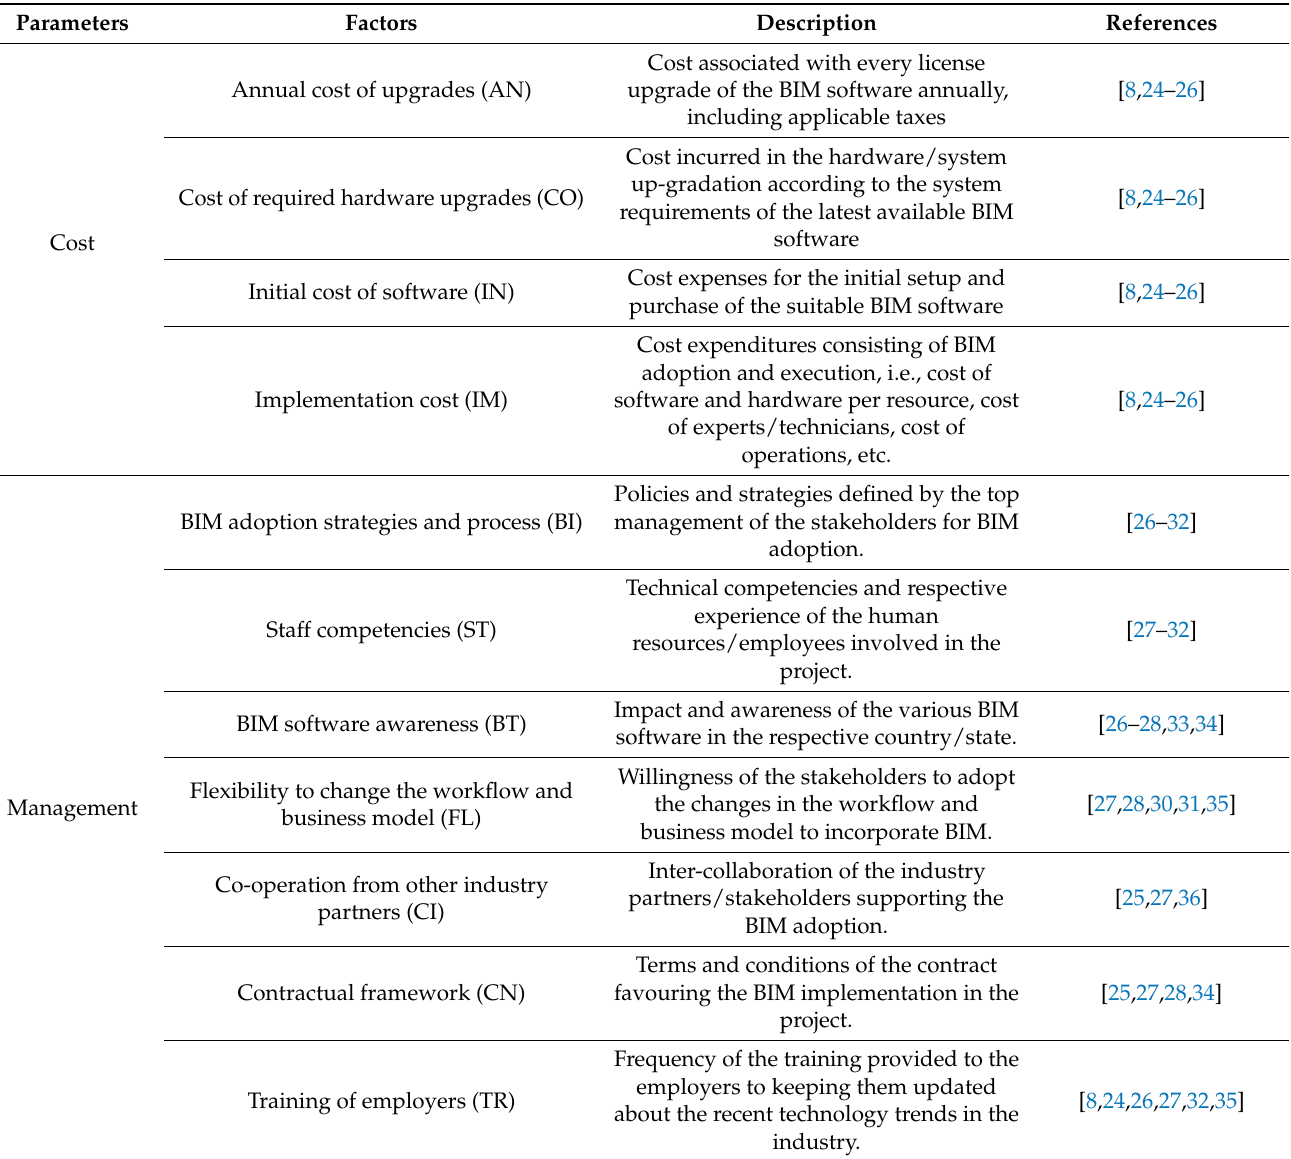
Table 1. Factor identification from the